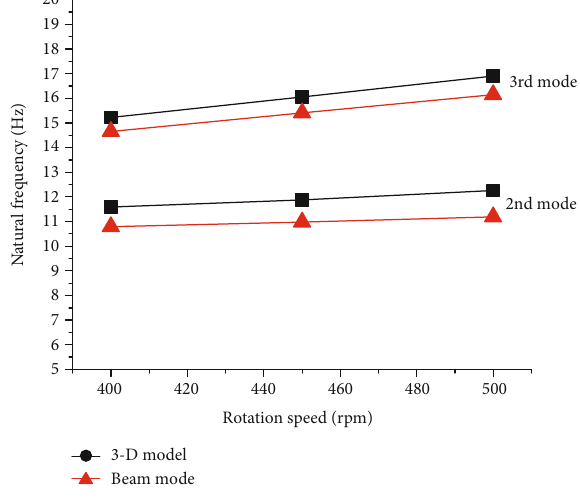
Figure 12: Natural frequencies ( AR = 18 : 07 ).